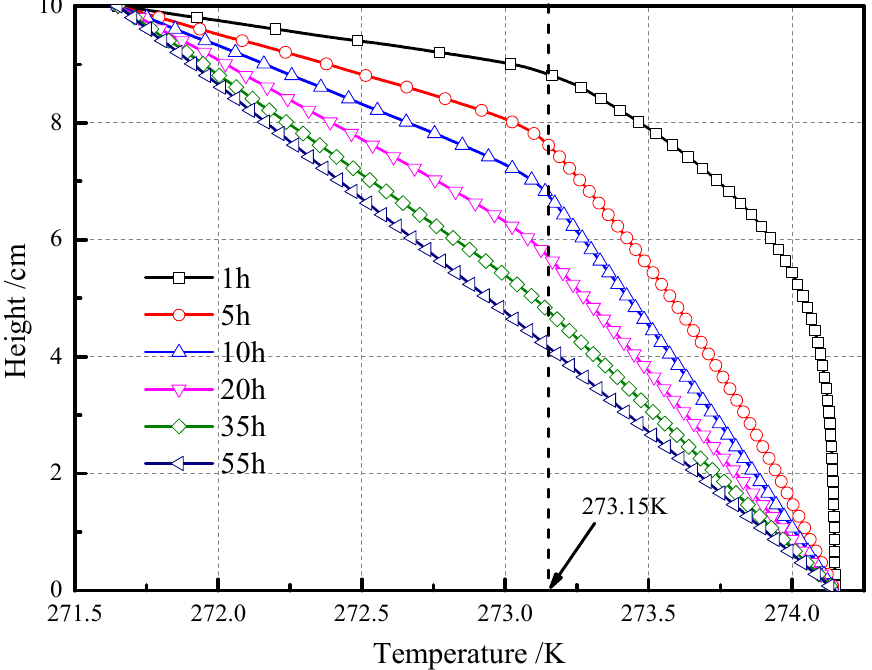
Figure 6. Temperature distribution at different times of case 2.